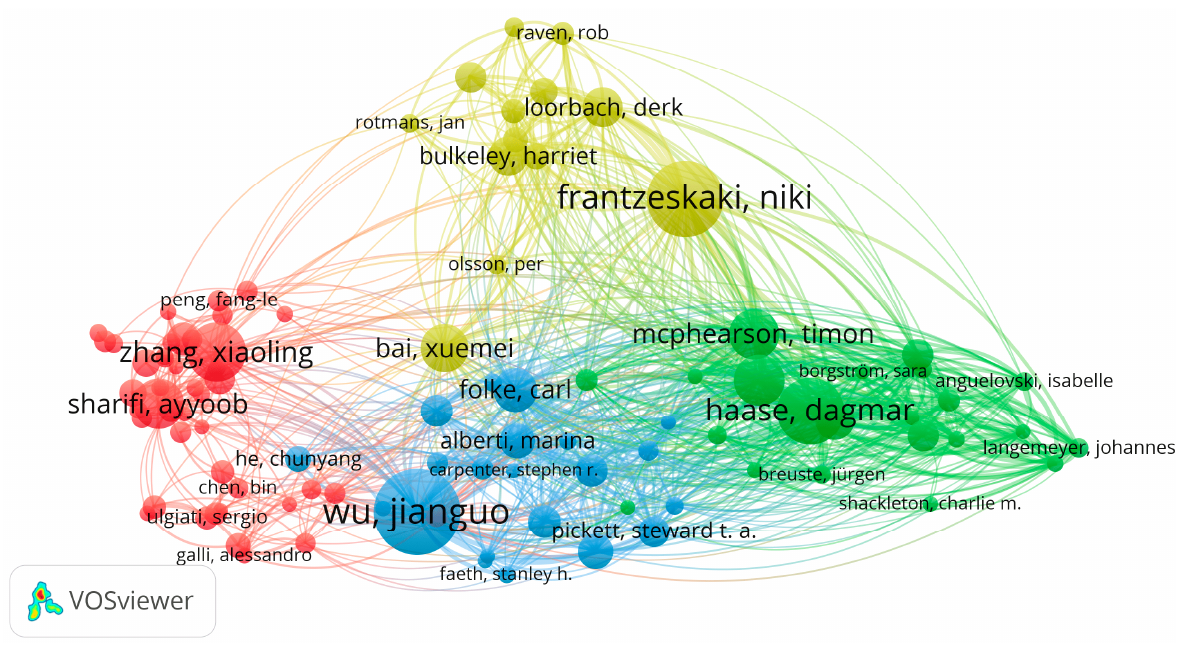
Figure 4. A co-authorship analysis (the node size is proportional to the number of citations).